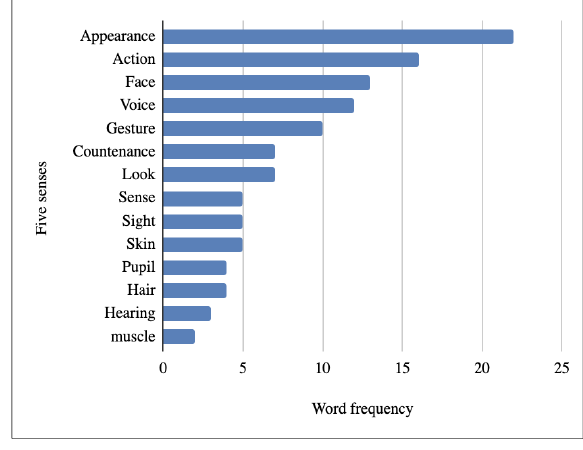
Figure 6. Word Frequency Ranking for the ‘Five Senses’.